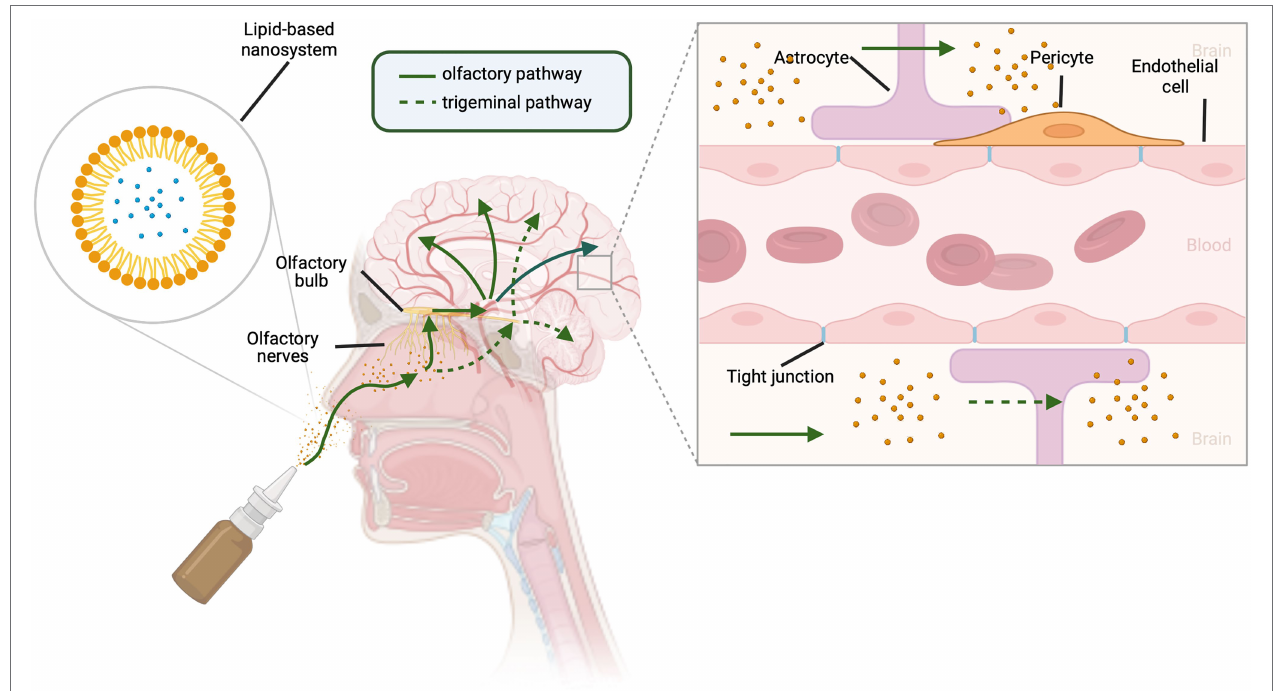
FIGURE 1 | Routes for intranasal delivery of drugs to the central nervous system. Lipophilic drugs can be packaged in lipid-based carrier systems. Upon entering the nasal cavity, drugs can reach the brain by either olfactory (solid green lines) or trigeminal nerve (dotted green lines) pathways. Traversing branches of the trigeminal nerve, drugs enter the brain via the trigeminal ganglion and brainstem. Olfactory neurons send cilia into the nasal cavity lumen, a major site for drug absorption, providing access to the olfactory bulb and then to the brain. This allows drugs to bypass the endothelial cells, pericytes, astrocytes, and tight junctions that form the blood brain barrier. Created with